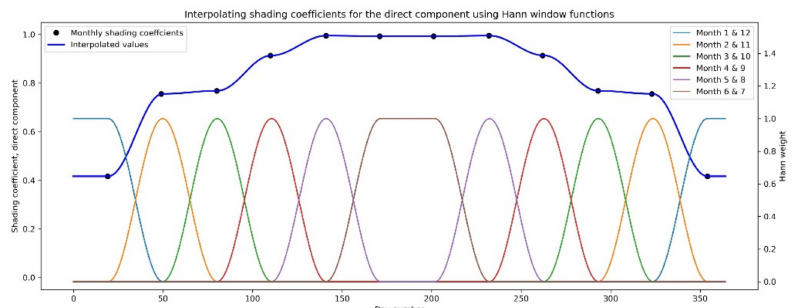
Figure 2. An example of the dynamic evolution of the shading coefficient for the direct component throughout the year (thick blue line). Six fix shading coefficients (black dots), distributed symmet- rically around the winter/summer solstice, were interpolated to any time of the year using the six corresponding Hann weighting functions (thin colored